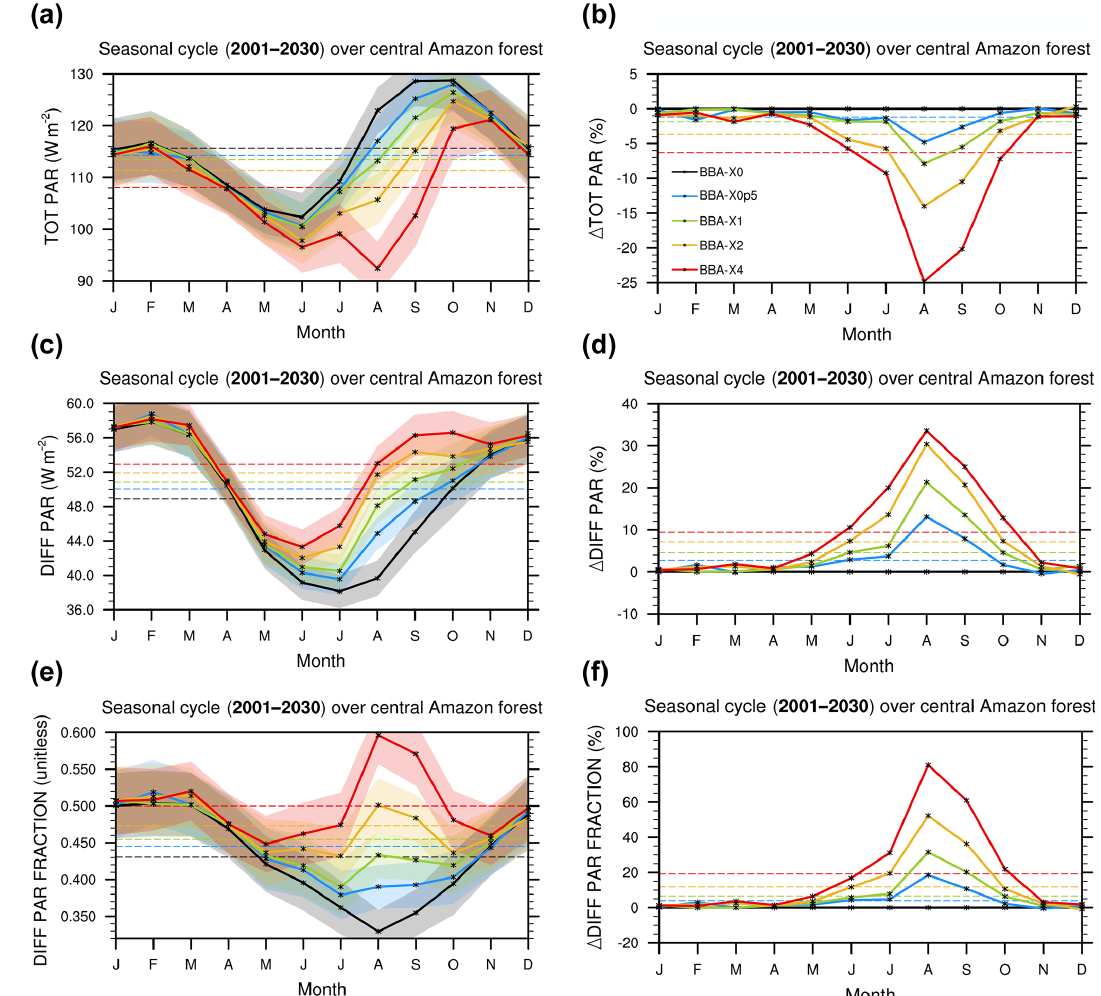
Figure 3. Modelled seasonal cycle from HadGEM2-ES for the total PAR ( a, b ), the diffuse PAR ( c, d ) and fraction of radiation that is diffuse ( e, f ) for the five BBA emission experiments. Absolute values ( a, c, e ) and relative anomalies ( b, d, f ) w/r to experiment BBAx0 (i.e. no biomass burning aerosols) are shown. Transparent coloured areas in panels (a, c, e) correspond to ± 1 standard deviation. Dashed lines are the multi-year annual